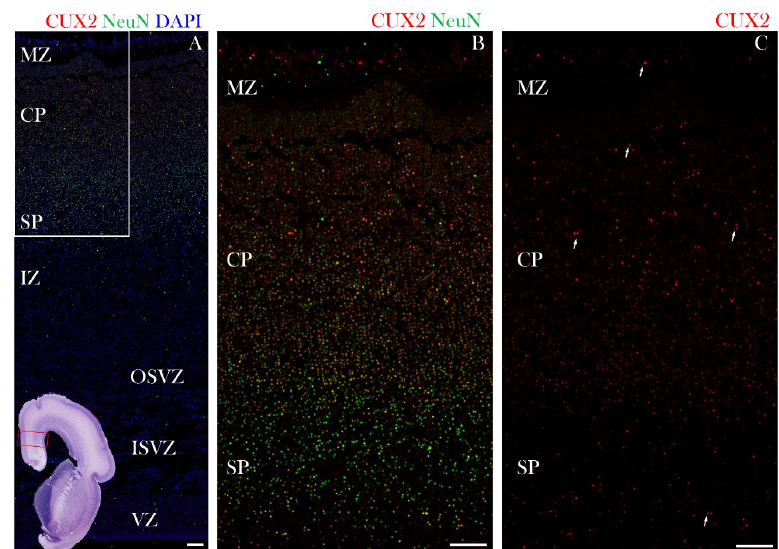
Figure 4. CUX2 is expressed in the MZ, CP and SP during the SP expansion phase at 17 PCW. ( A , B ) Coronal section of developing neocortex (indicated by red box in the Nissl stained complete scan of the coronal section in lower left corner), was immunostained for CUX2 (red), neuronal marker NeuN (green) and DAPI (blue) at 17 PCW. In the medial portion of the developing frontal cortex (red box on the Nissl overview image in the lower left corner shows where the images were taken), during the expansion of the SP at 17 PCW. ( B , C ) Representative higher magnification confocal images of box A in upper left corner. Strong CUX2+ nuclei were found in the upper half of the CP. In the lower half of the CP, weaker CUX2 nuclear reactivity was present, along with scattered CUX2+ nuclei in the SP and MZ (white arrows mark some of the CUX2+ nuclei). CUX2+ nuclei co-localize with NeuN reactive nuclei. OSVZ, Outer Subventricular Zone; ISVZ, Inner Subventricular Zone. Scale bar = 100 µ m.